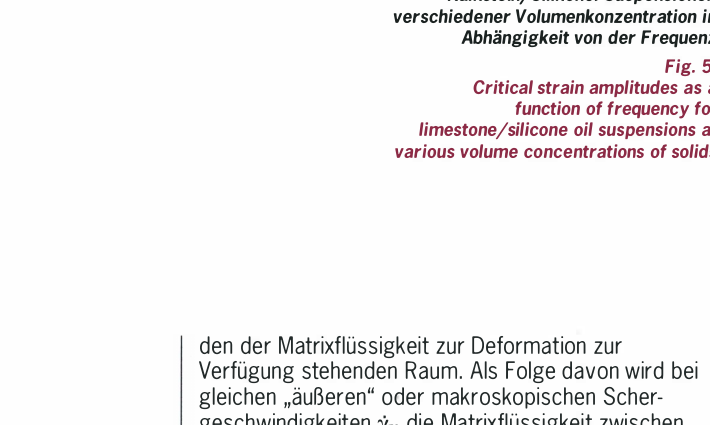
Fig. 5: Critical strain amplitudes as a function of frequency for limestone/silicone oil suspensions